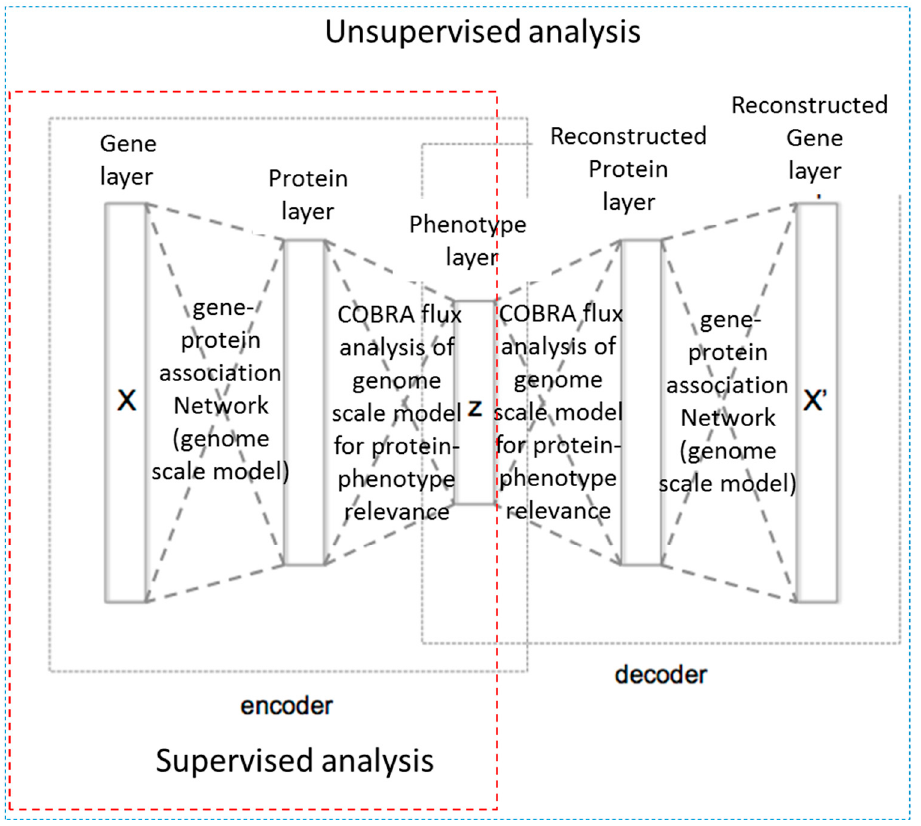
Figure 6. Schematic representation of the DeepMetabolism approach by Guo et al. [81].